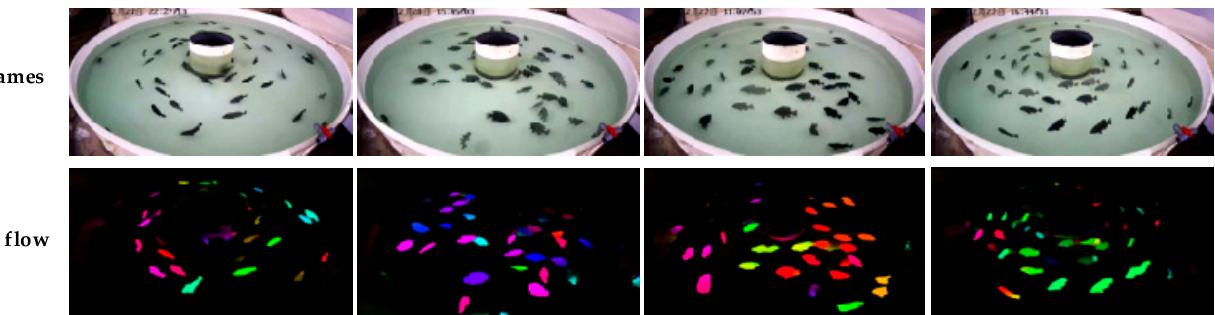
Figure 4. Keyframes and optical flow estimation in a video sequence. FlowNet2 is an optical flow prediction method based on CNN, which models optical flow prediction as a supervised deep-learning